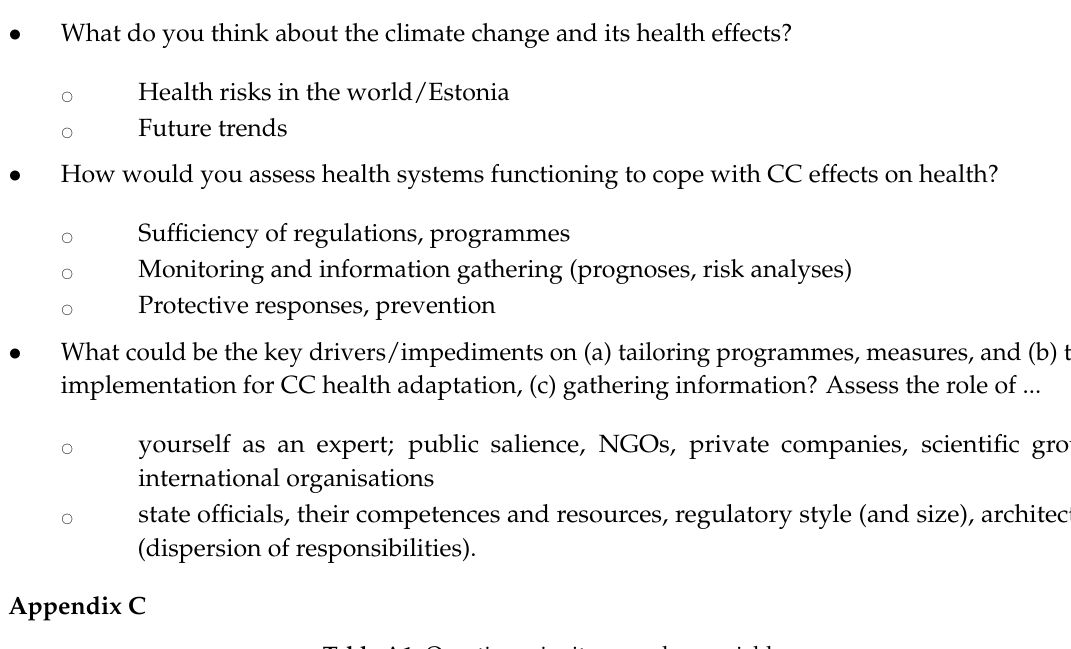
Table A1. Questionnaire items on key